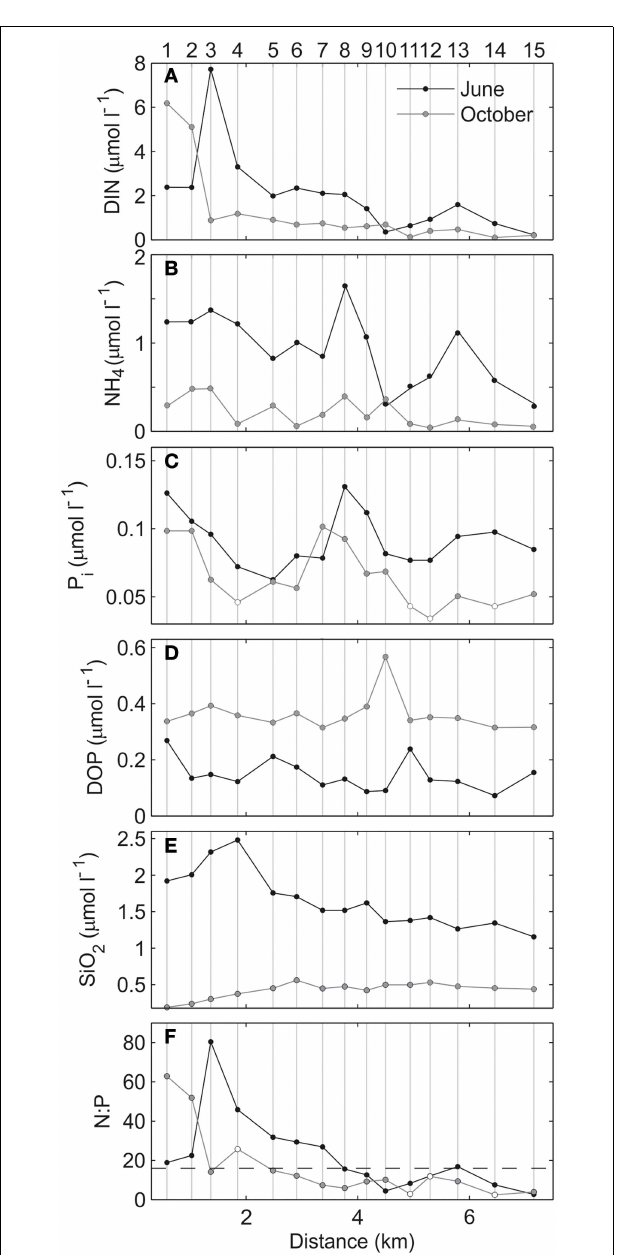
FIGURE 4 | Surface (A) DIN, (B) NH 4 , (C) P i , (D) DOP, (E) SiO 2 , and (F) N:P ratio for June (black) and October (gray) surveys. The dashed back line in (F) indicates the Redfield ratio (16:1). White dots indicate values affected by the limit of detection